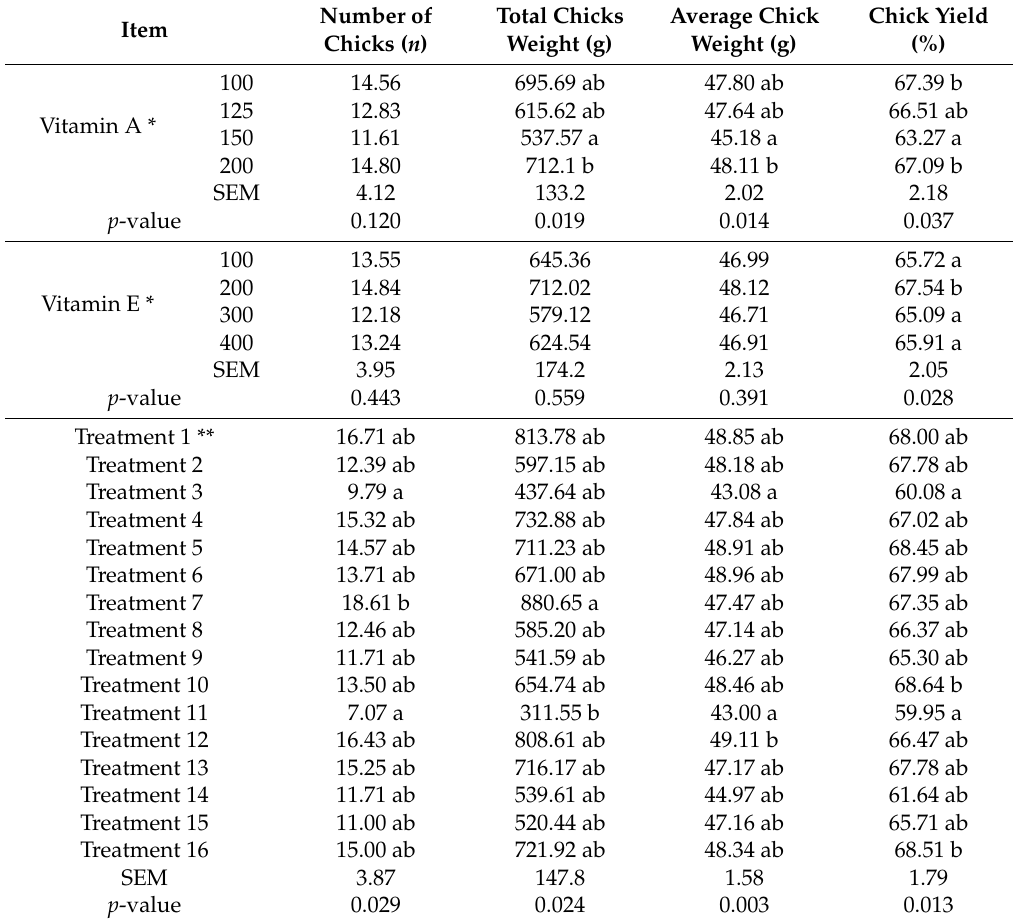
Table 4. Effect of dietary treatments on chick-related parameters.